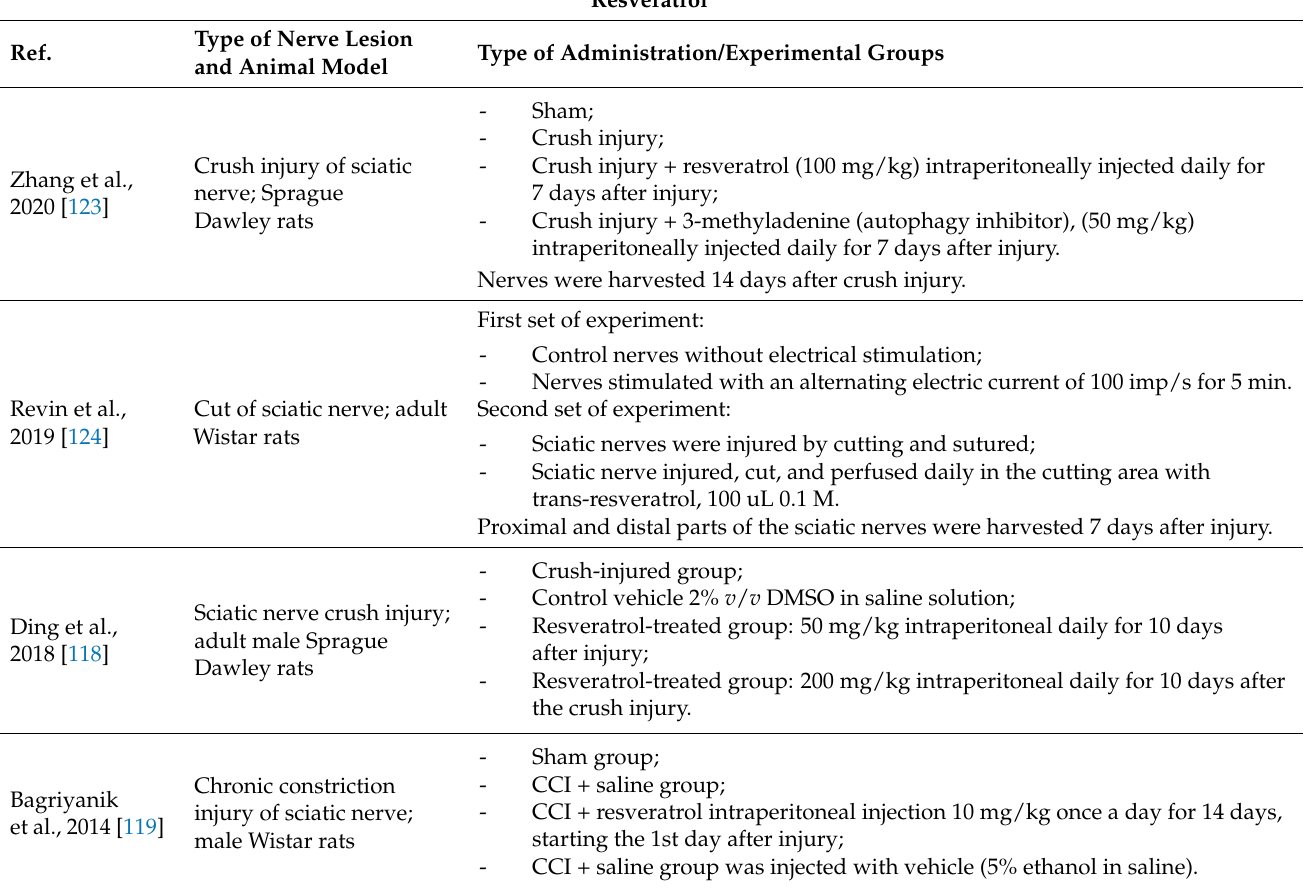
Table 8. Stilbenes: Table showing the experimental method (type of nerve injury and animal model), the dose, and method of administration of resveratrol. Included references are listed ascending in accordance to their publication